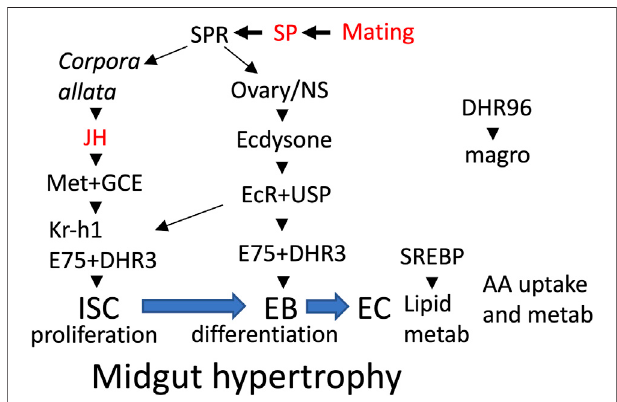
FIGURE 1 | Midgut remodeling overview. Mating and male SP activate SP receptor (SPR) in multiple tissues ( Corpora allata , ovary, nervous system), resulting in increased production of the hormones JH and ecdysone. In the midgut, JH acts through its receptors Met+GCE to activate proliferation of intestinal stem cells (ISC) and the production of their progeny the enteroblasts(EB).Alsoinmidgut,ecdysoneactsthroughitsreceptorEcRand cofactor USP to increase expression of the hormone receptor (HR) gene E75, and activation of transcription factor Kr-h1, which in turn promotes ISC proliferation and differentiation of EBs to enterocytes (EC). In the ECs, transcriptionfactorSREBPactivatesgenesforlipidmetabolismanduptake.In proventriculus cells, thehormone receptor DHR96 activates expression ofthe magro lipase, which is released into the midgut lumen. Mifepristone has been shown to block the life-span shortening effects of mating, SP and the JH- analog methoprene (indicated in red font).